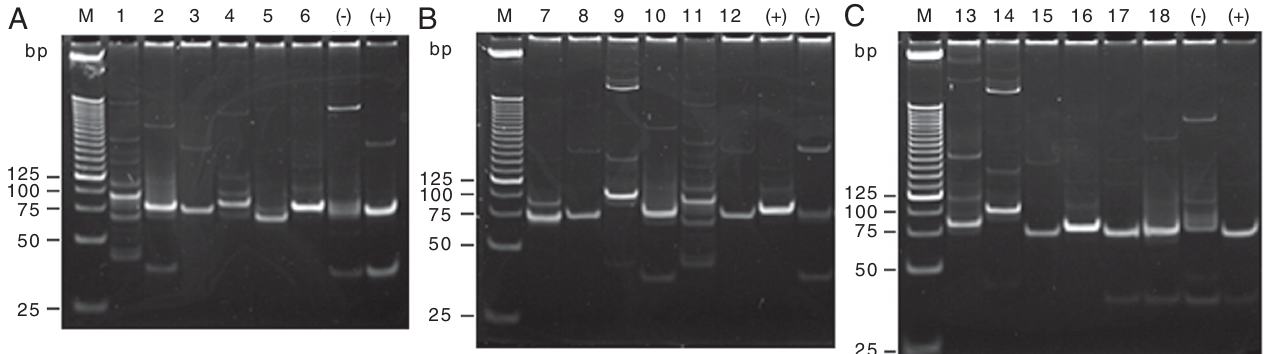
Figure 3. Confirmatory PCR for clonal rearrangement detection in leukemic patients. Panels A , B and C present the results of the confirmatory PCR for clonal rearrangement detection in the 18 leukemic patients (A: patients 1-6; B: patients 7-12; C: patients 13-18). Some patients presented an oligoclonal pattern of rearrangement, and only the strongest band was selected for presentation. M = marker of DNA size; bp = base pairs; (+) = positive control; (-) = negative control; N = negative result, or